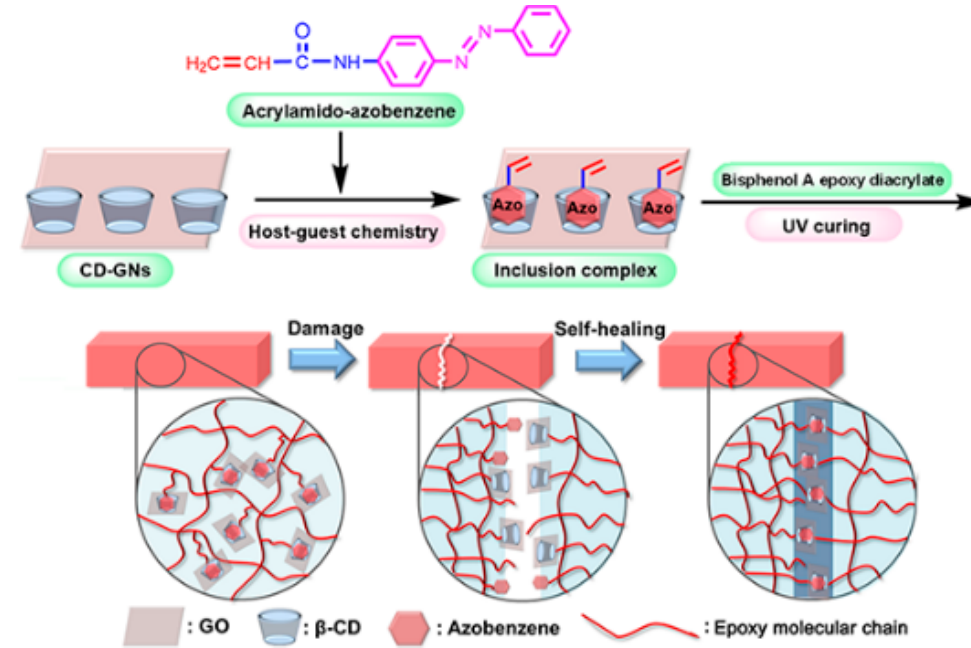
Figure 12. Schematic illustration of the self-healing mechanism of epoxy composite films. (Reprinted with permission from [89]. Copyright American Chemical Society, 2018).